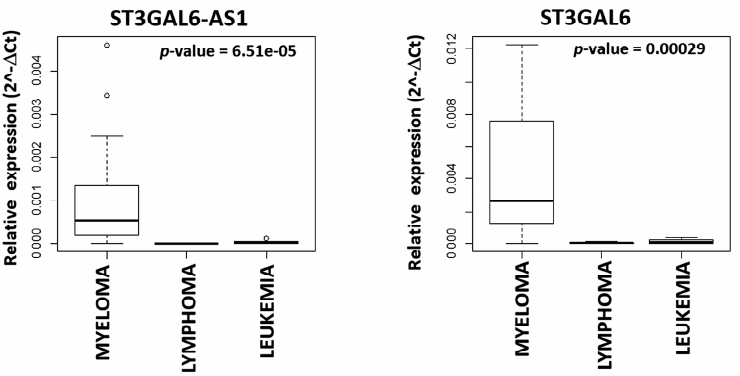
Figure 4. Boxplot of ST3GAL6-AS1 and ST3GAL6 expression in 21 MM, six lymphoma, and five leukemia cell lines based on the qRT-PCR approach described in the Supplementary methods.